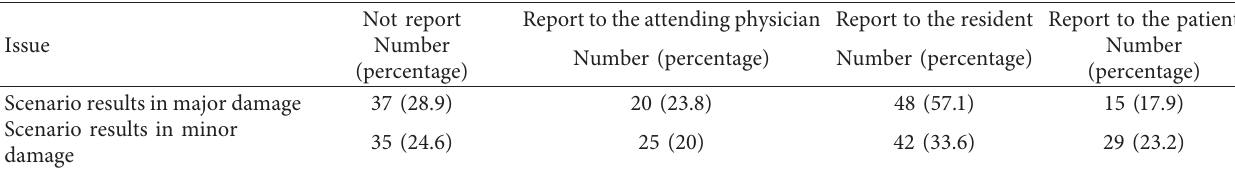
Table 8: Participant’s response to